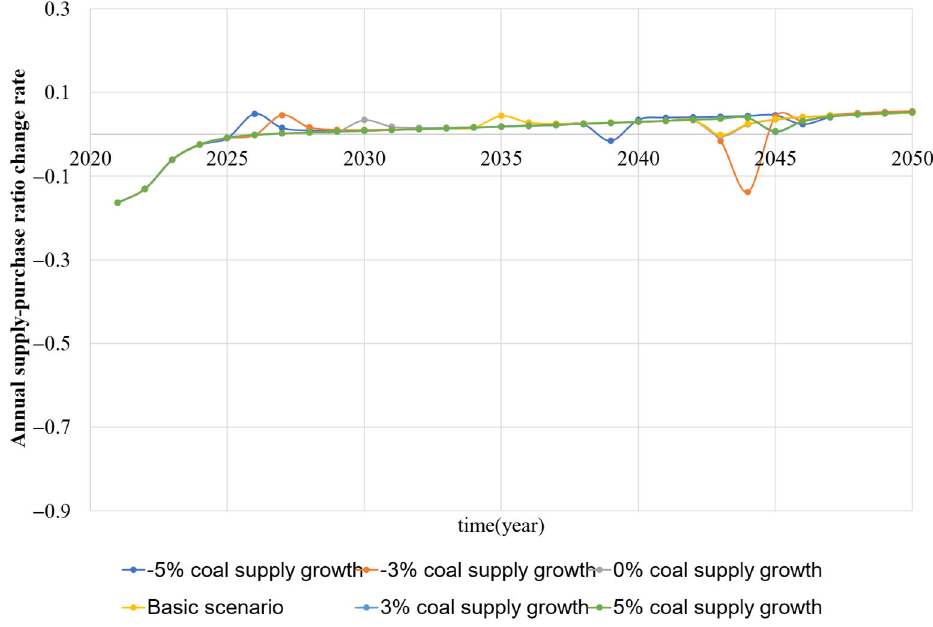
Figure 8. Trend chart of annual supply–purchase ratio based on coal supply growth rate.